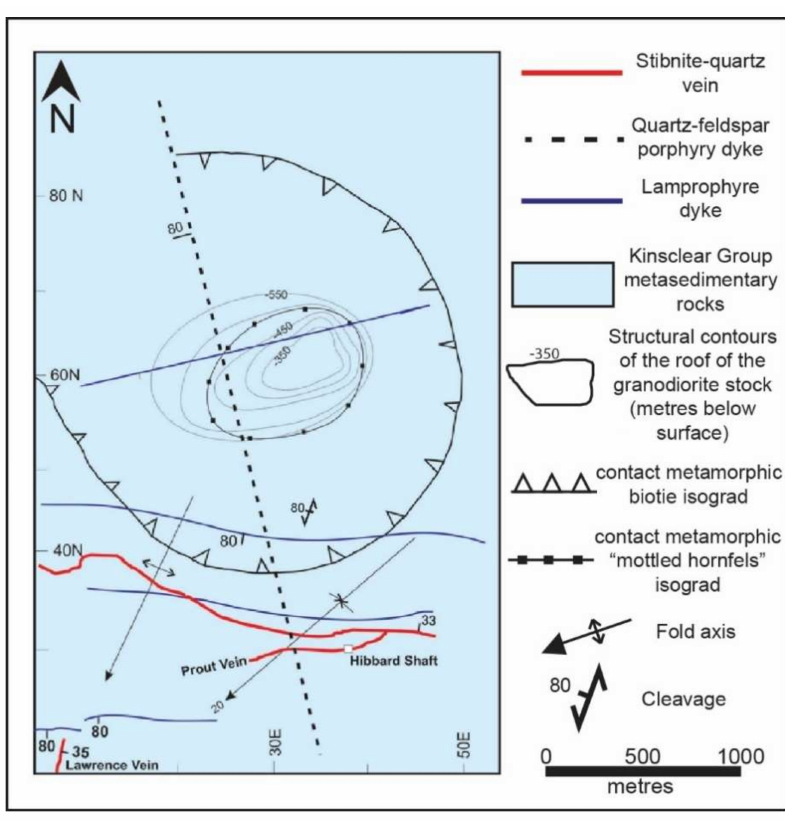
Figure 2. Geological map of the Lake George mine, illustrating the granodiorite stock contoured at depth, the quartz–feldspar porphyry dyke, the lamprophyre dykes, and vein systems in the area (modified from